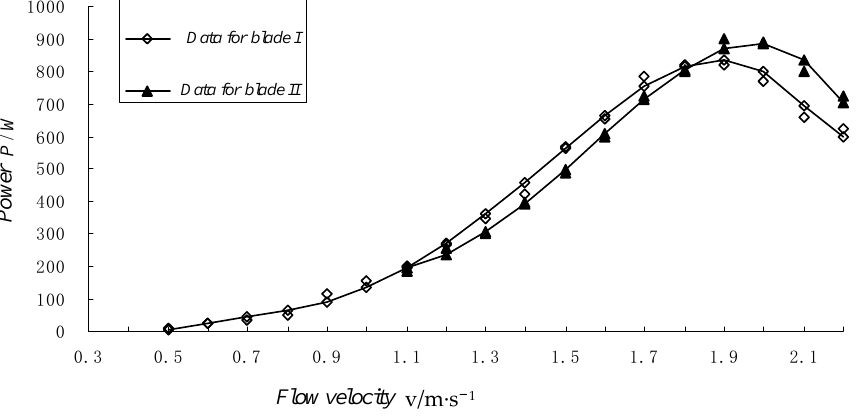
Figure 16. Power of the blade at different velocities.